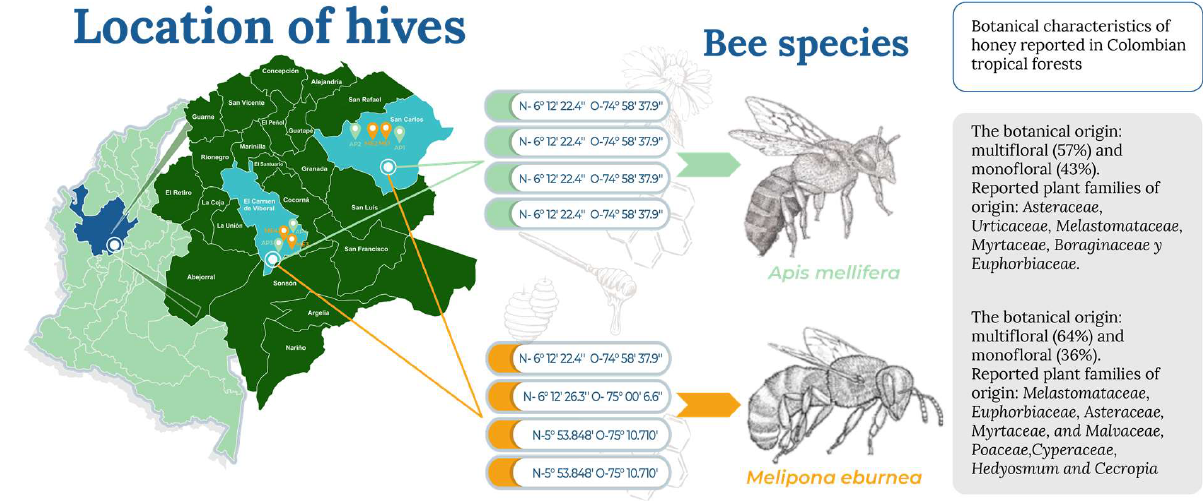
Figure 1. Location of sampled hives, morphological illustrations, and botanical characteristics of the honeys produced by A. mellifera and M. eburnea reported in tropical forests of Colombia. Botanical characterization of honey adapted from [12].